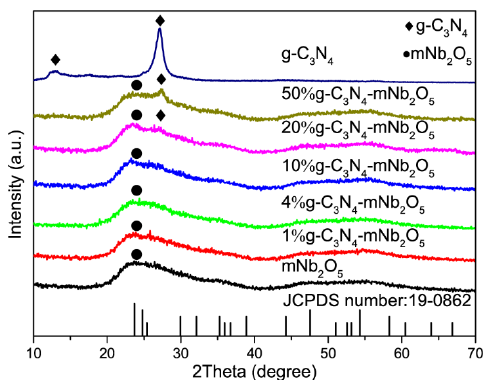
Figure 1. XRD patterns for mNb 2 O 5 , g-C 3 N 4 and g-C 3 N 4 -mNb 2 O 5 composites with different contents of g-C 3 N 4 .